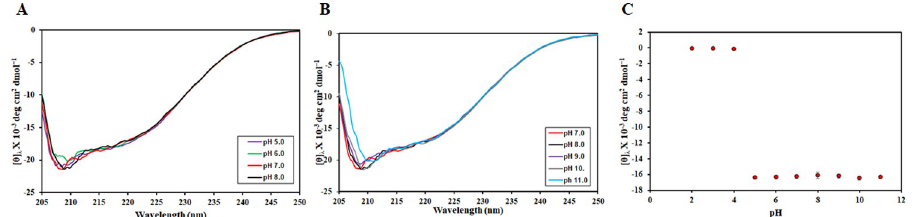
Fig 1. Changes in the secondary structure of CDK6 measured by far-UV CD. (A) Far-UV CD spectra of CDK6 in the pH range of 2.0–8.0 (B) Far UV CD spectra of CDK6 in alkaline pH range (7.0–11.0) (C) A plot of MRE at 222 nm ( θ 222 ) as a function of